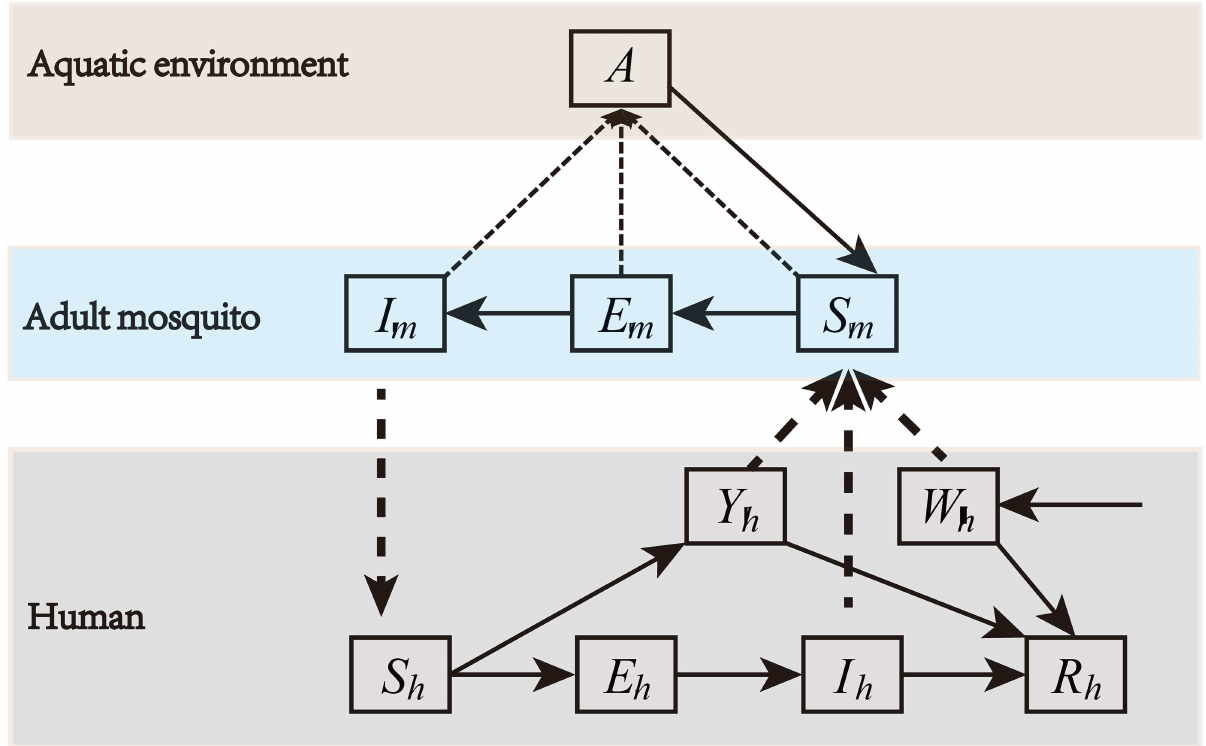
Fig 4. The transmission of dengue virus between mosquitoes and humans. Black dash-dotted lines show directionof transmission betweenhumans and mosquitoes. For mosquito, A denotesimmature stage, and M describesmature mosquito stage (includingsusceptible S m , incubating E m , and infectious I m ), and M = S m + E m + I m . For human, all hosts are dividedinto six stages for denguetransmission: susceptible S h , incubating E h , asymptomatic infectious Y h , infectious I h , importedinfectious W h and recovered R h , where N h = S h + E h + Y h + I h + W h + R h is the total